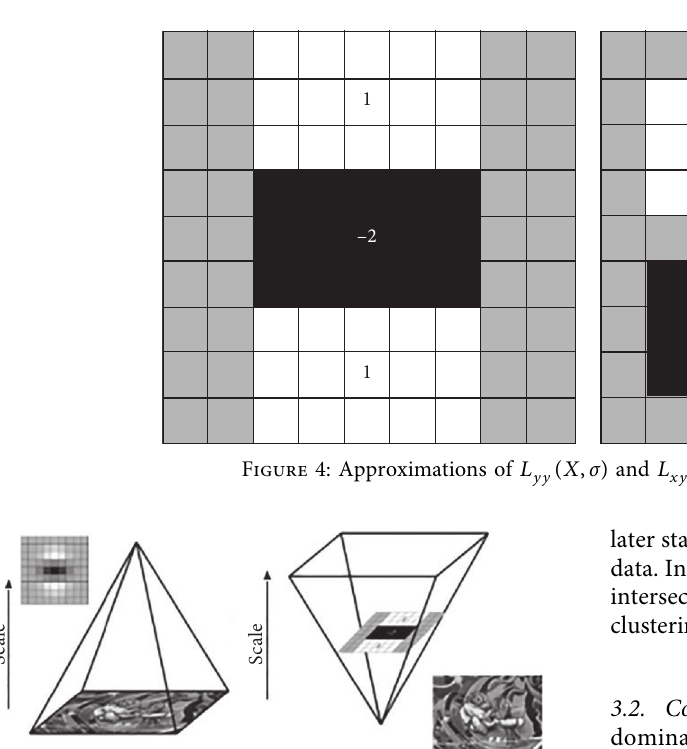
Figure 5: The traditional and SURF approach of constructing scale